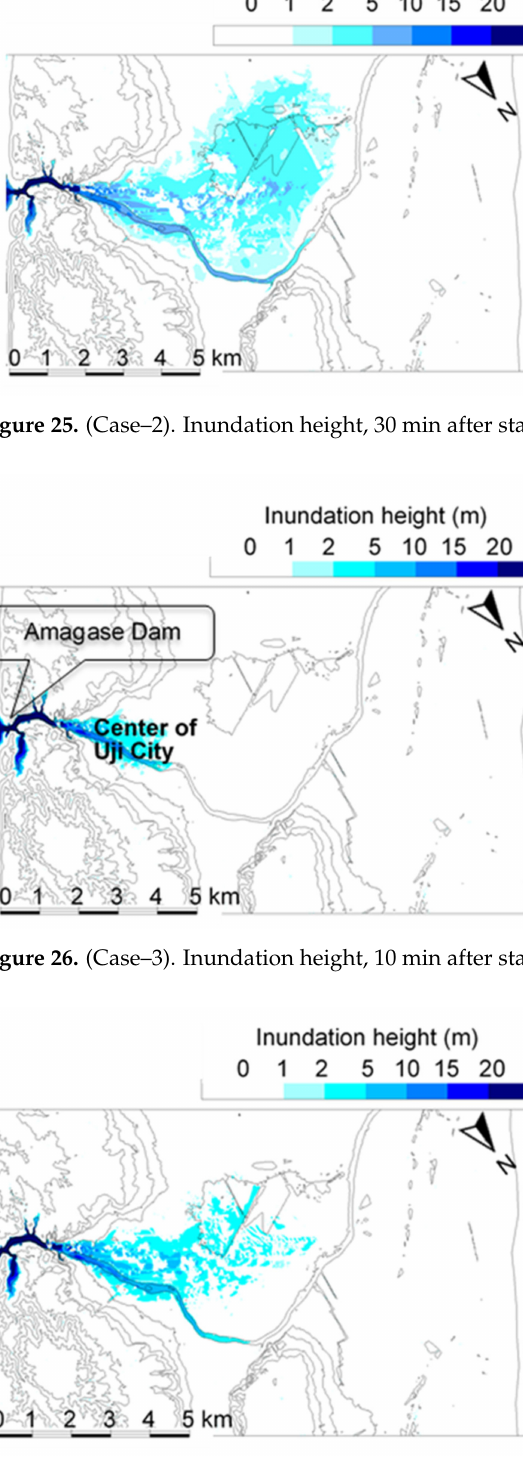
Figure 27. (Case–3). Inundation height, 20 min after start of the